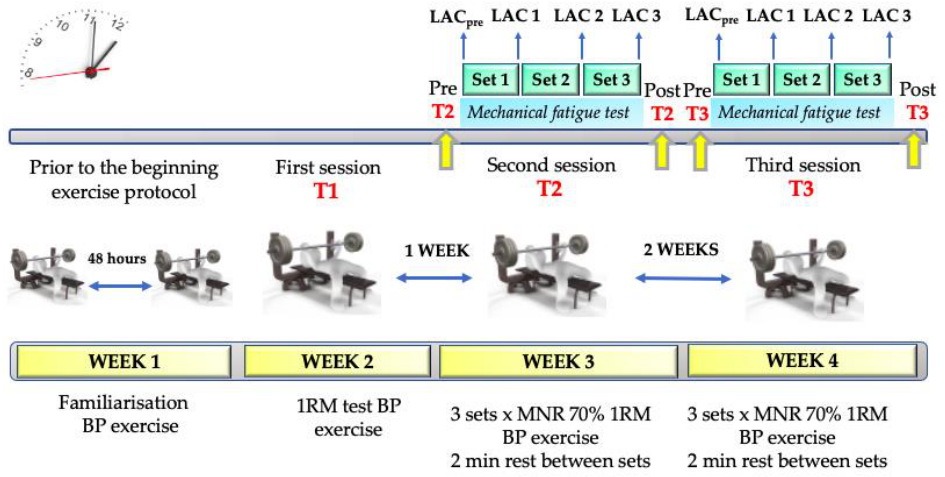
Figure 1. Study design. BP = bench press; LAC = blood lactate concentrations; 1RM = one-maximum repetition test; MNR = Maximum Number of Repetitions; Min = minutes.